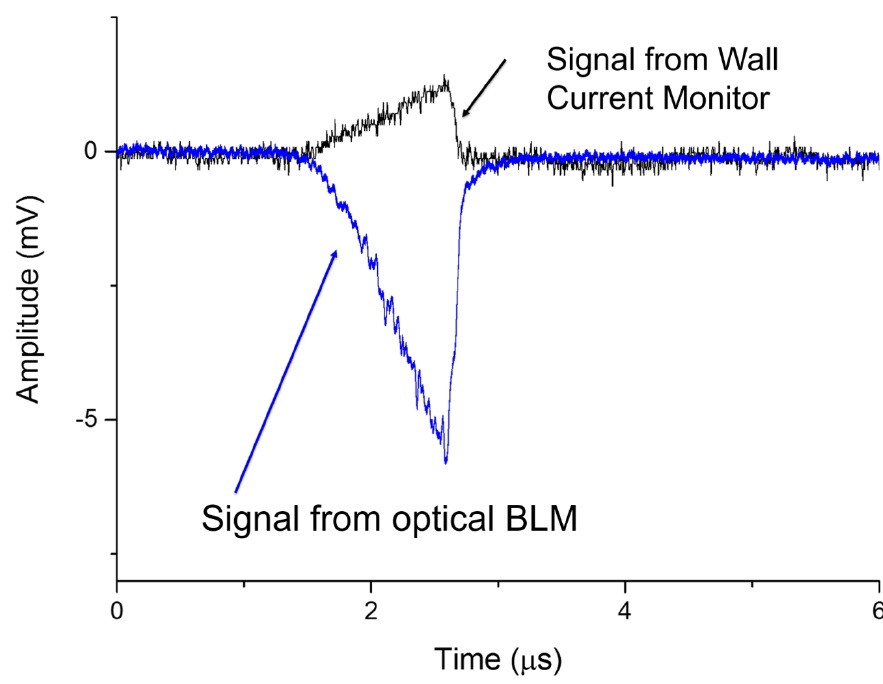
Figure 11. The Cherenkov signal for one fibre as a function of time in comparison with the wall current monitor signal, during a 10 MW 2 µ s input pulse of RF power.